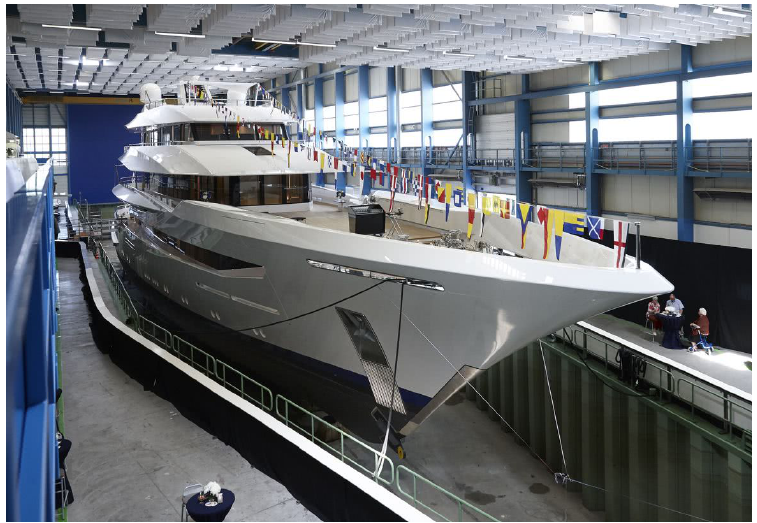
Figure 2. Conventional bow example.